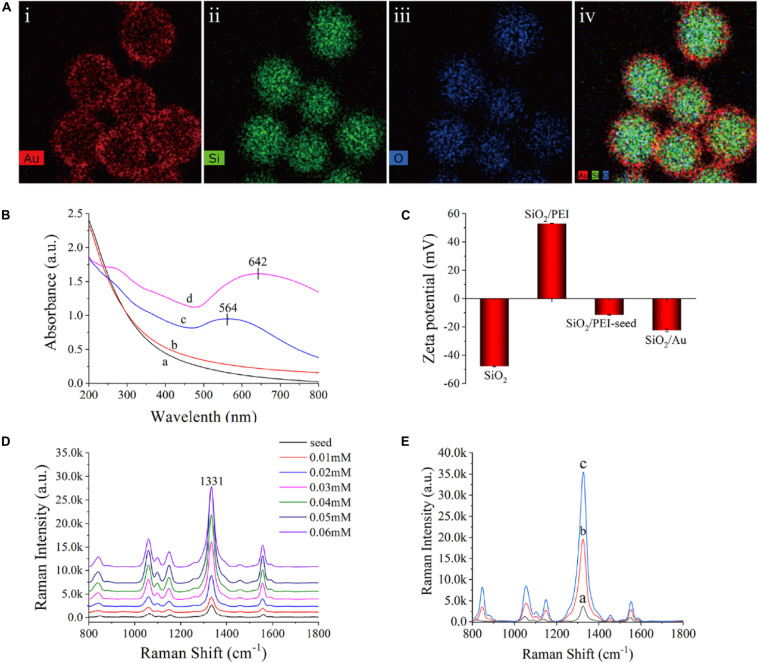
(A) Element mapping of SiO2/Au NPs (i–iv). (B) UV-vis spectra of SiO2 (curve a), SiO2/PEI (curve b), SiO2/PEI-seed (curve c), and SiO2/Au (curve d). (C) Zeta potential of SiO2, SiO2/PEI, SiO2/PEI-seed, and SiO2/Au. (D) Raman intensity of SiO2/seed/DTNB/Au NPs with different concentrations of HAuCl4: 0.01, 0.02, 0.03, 0.04, 0.05, and 0.06 mM. (E) Raman spectra of SiO2/PEI-seed/DTNB (curve a), SiO2/Au/DTNB (curve b), and SiO2/DTNB/Au/DTNB (curve c).